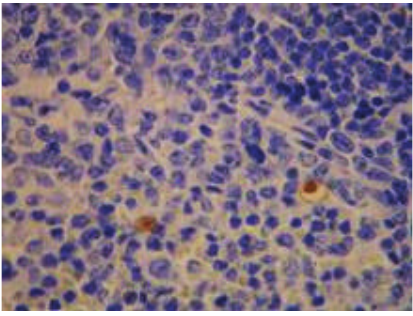
Figure 1: Model control group—6 hours in SAP experiment spleen (several apoptoic cells), TUNEL × 400.